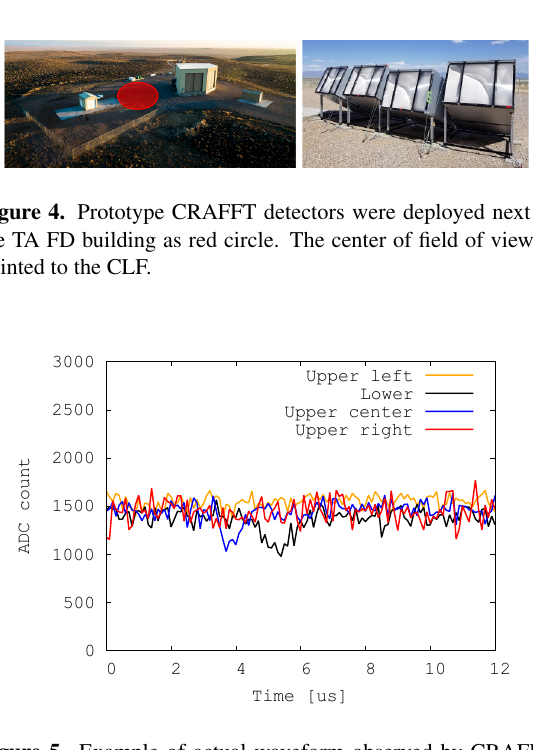
Figure 5. Example of actual waveform observed by CRAFFT detector. Vertical and horizontal axes are FADC count and time slot, respectively.